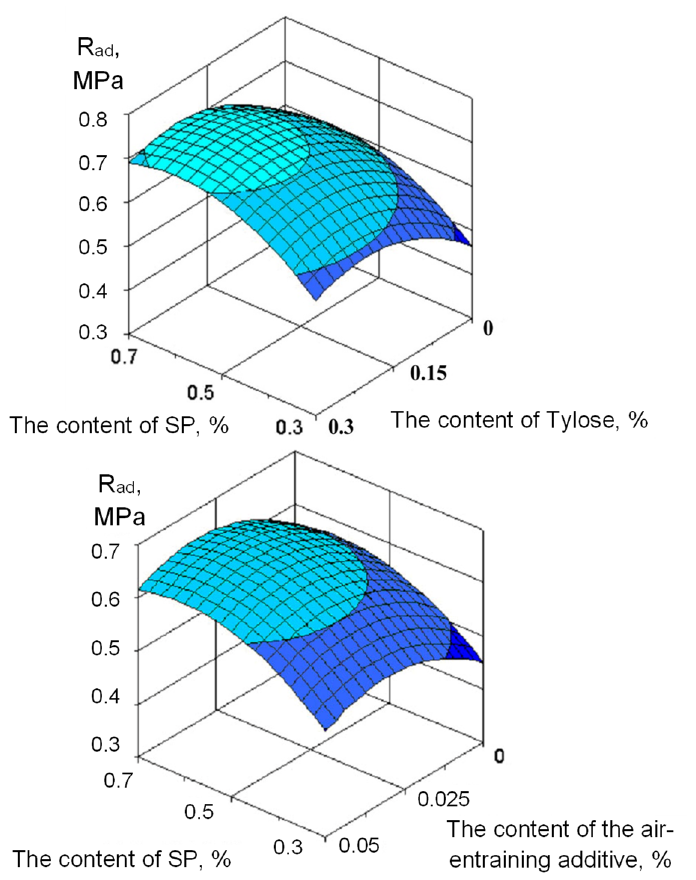
Figure 3. Dependences of adhesive strength (MPa) of cement–ash mortars at 28 days on the content of modifier additives.